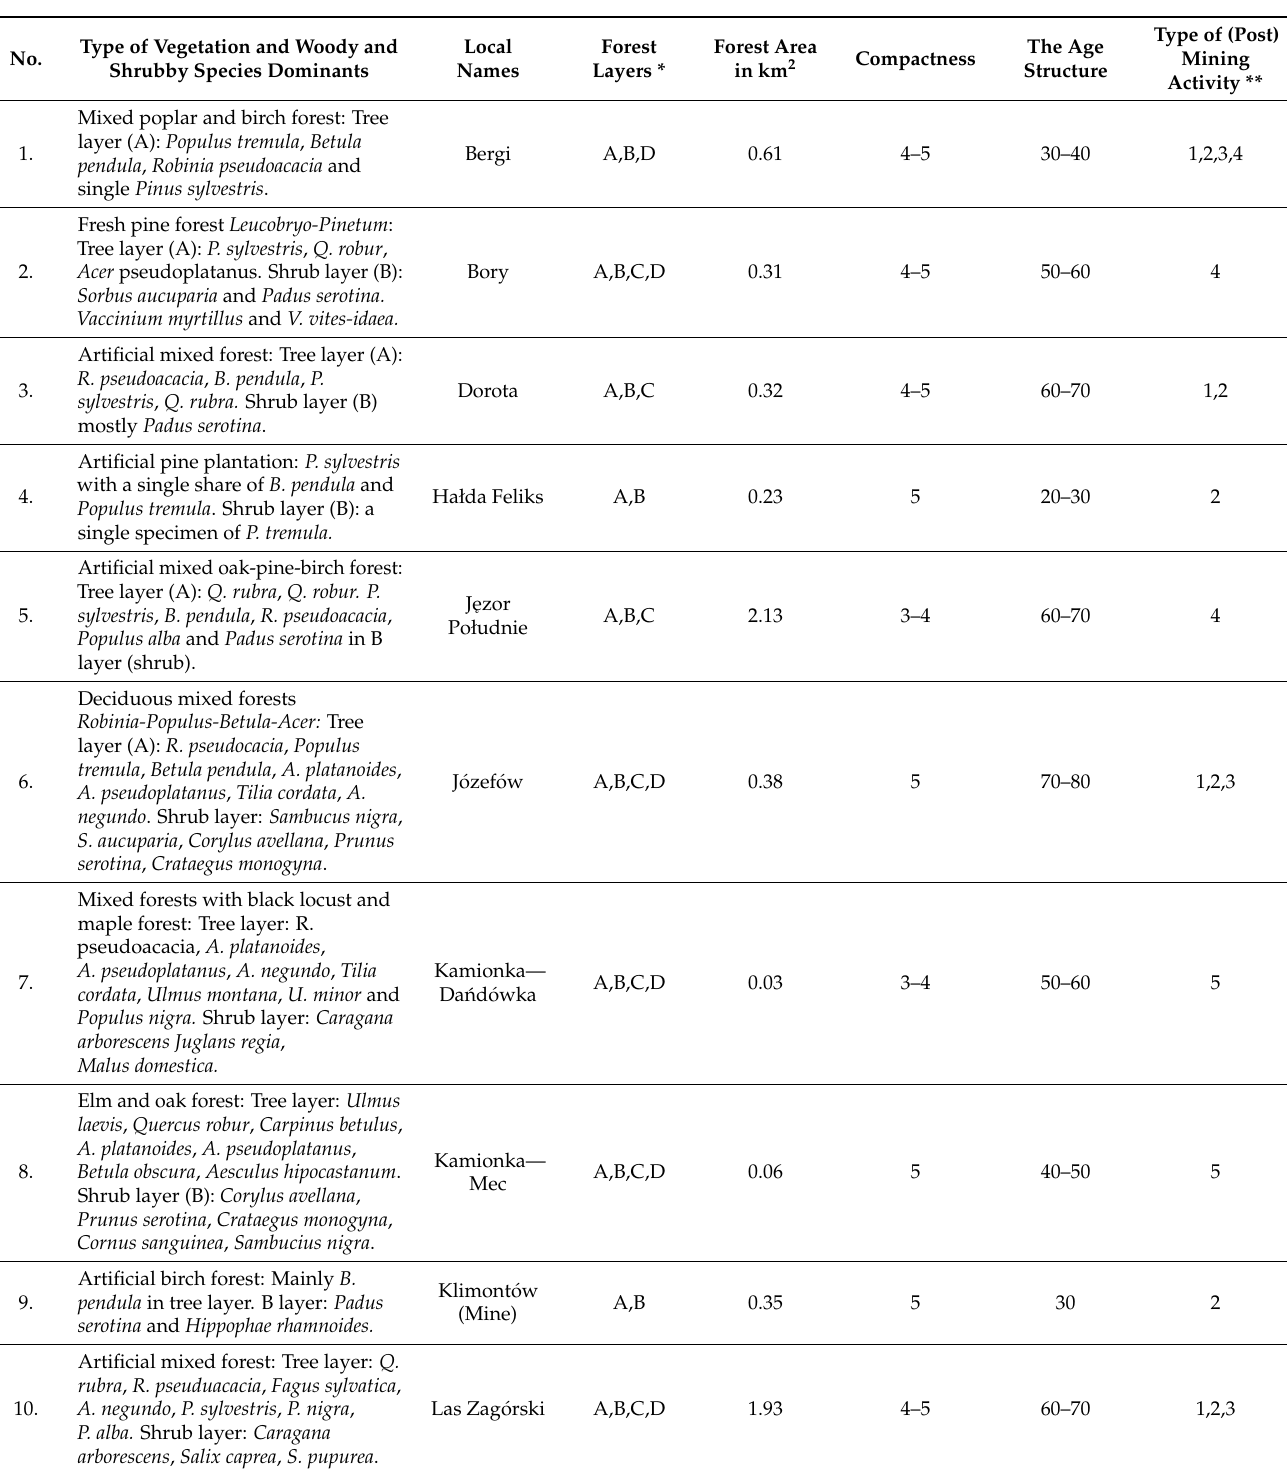
Table 2. General features of forest communities in the studied post-mining areas of Sosnowiec (source: the